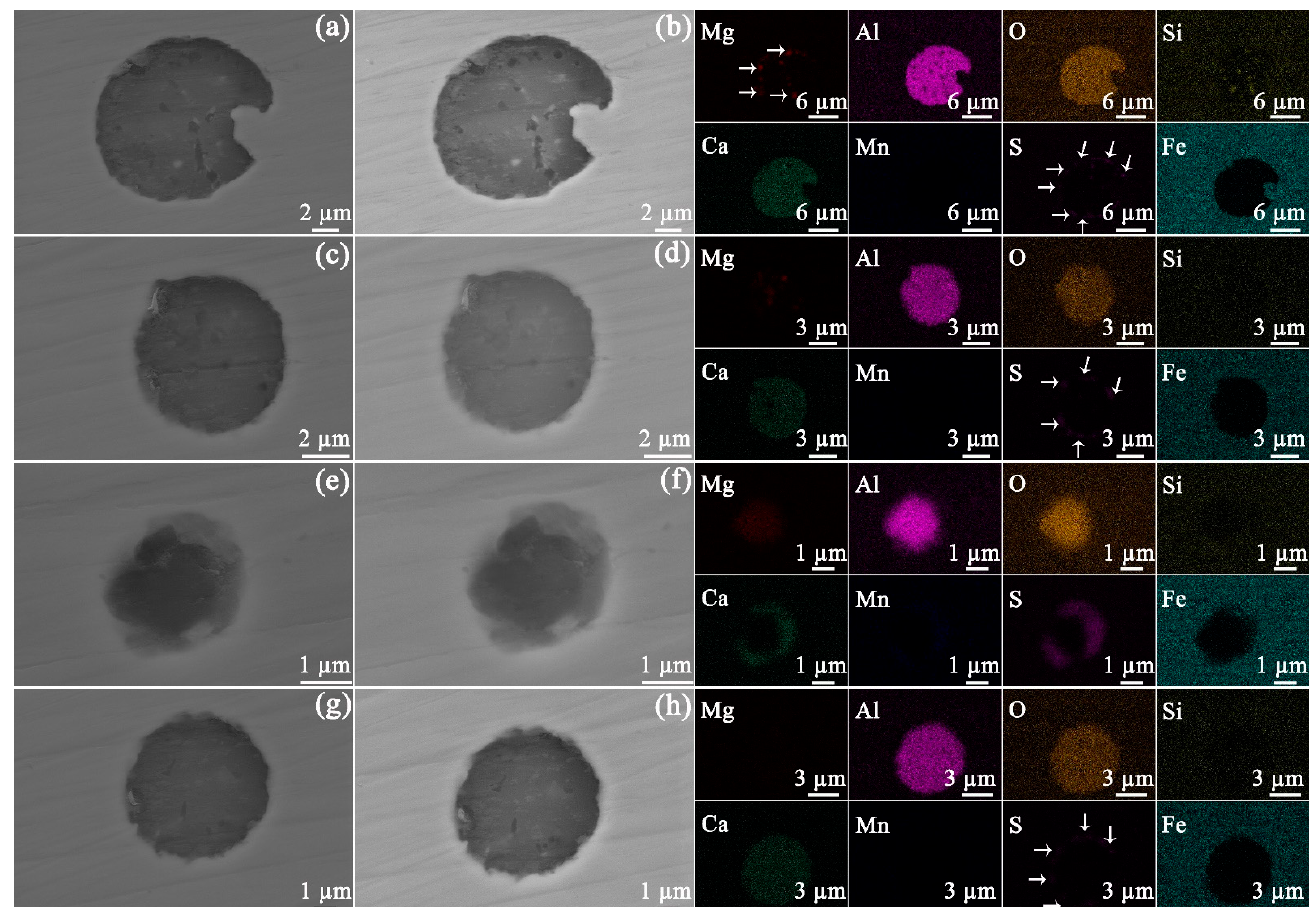
Figure 5. SEM SE images of the inclusion containing Mg − Al − Si − O − Ca − S before ( a ) and after ( b ) exposed to bitumen at 120 °C, of the inclusion containing Mg − Al − O − Ca − S before ( c ) and after ( d ) exposed to bitumen at 120 °C, of the inclusion containing Mg − Al − O − Ca − Mn − S before ( e ) and after ( f ) exposed to bitumen at 120 °C, and of the inclusion containing Al − O − Ca − S before ( g ) and after ( h ) exposed to bitumen at 120 °C. The elemental distributions of the inclusions are given at right. In the EDS maps given at right, the areas with low signal intensity are marked with arrows.